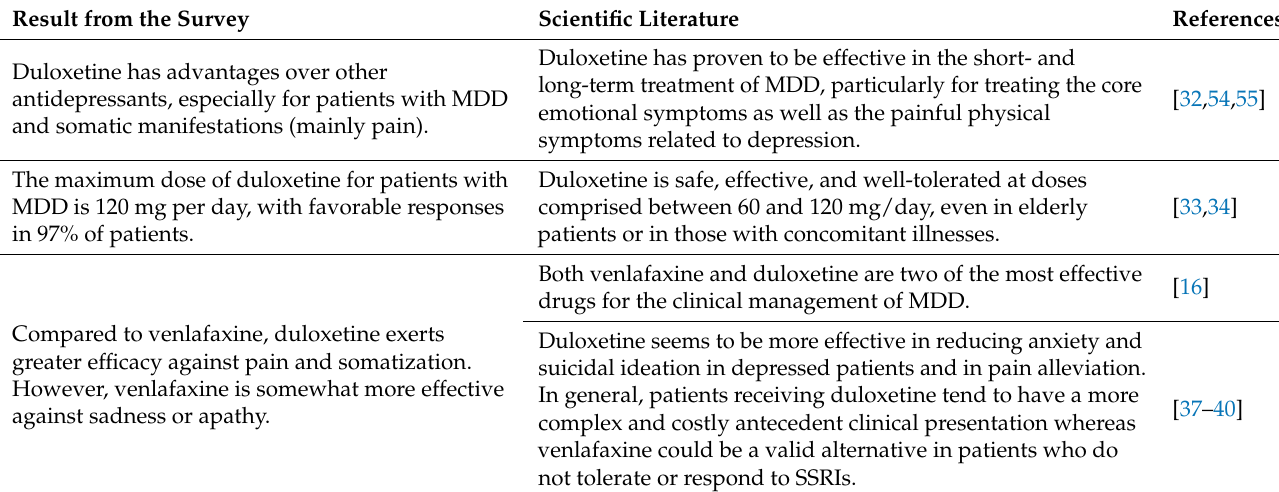
Table 2. A summary of the main results obtained in the questionnaire and the related scientific